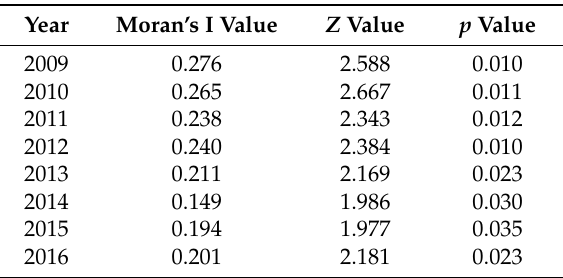
Table 4. The calculation results and related statistics of Moran’s I